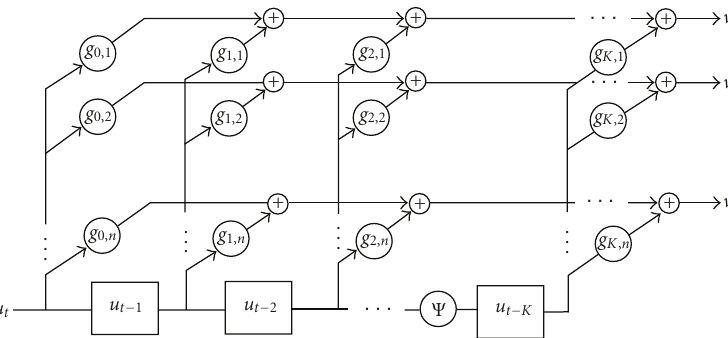
Figure 1: Rate 1 /n convolutional encoder over Z